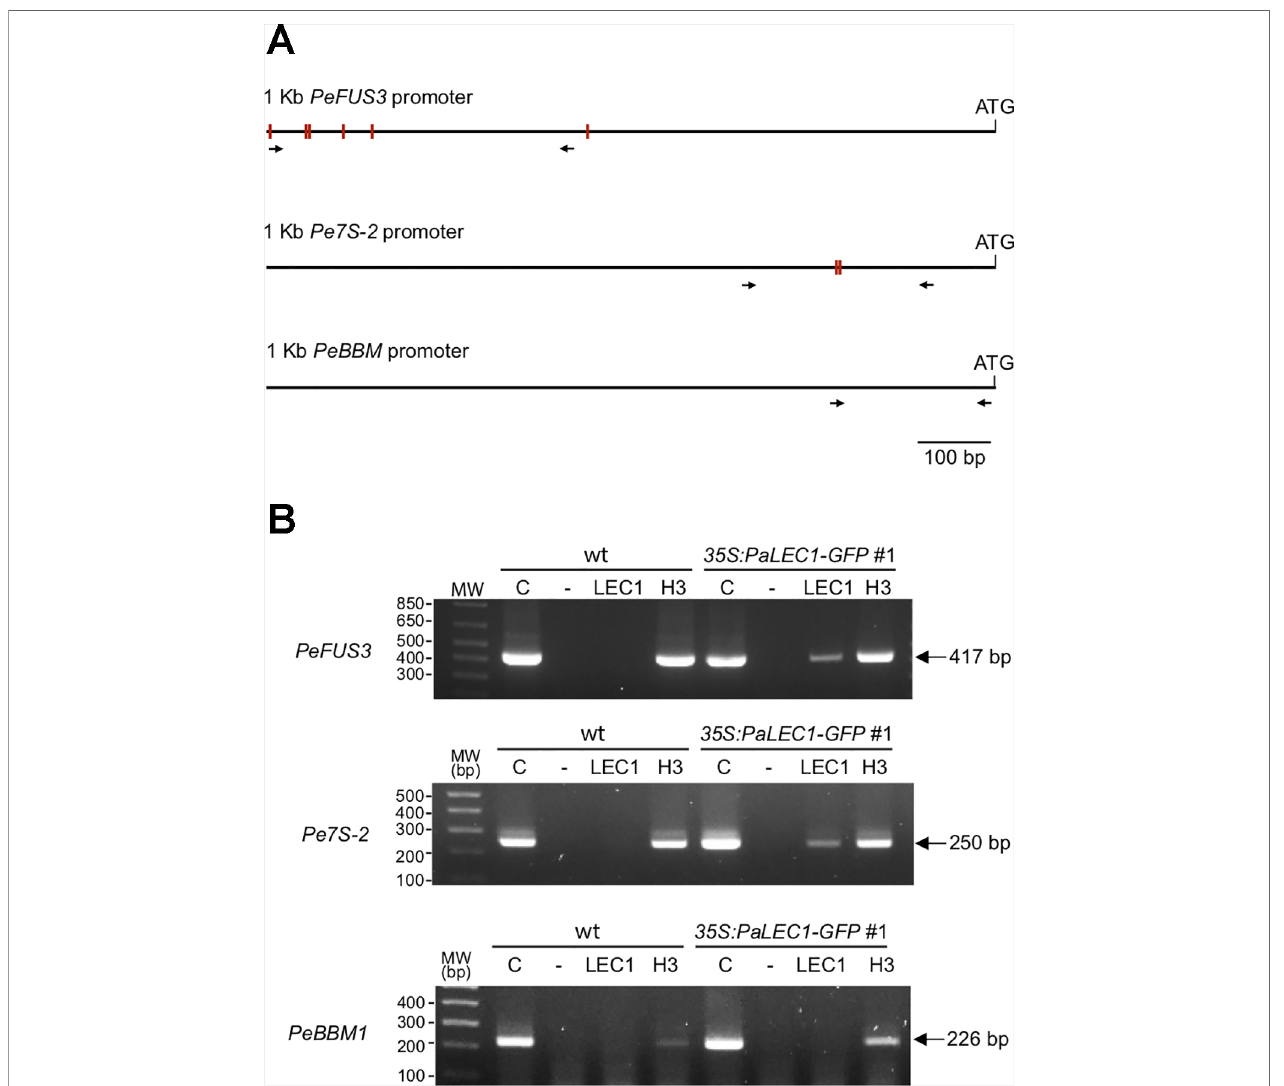
FIGURE 8 | Interaction between PaLEC1-GFP protein and the CCAAT element containing promoters. (A) Schematic representation of distribution of the CCAAT elements (red rectangles) in 1 kb upstream of the start codon of PeFUS3 and Pe7S-2 genomic DNAs. No CCAAT element was found in 1 Kb promoter region of PeBBM . Primers used for PCR reactions were shown as black arrows. (B) PCR of chromatin immunoprecipitation isolated DNA fragments to con fi rm interaction between PaLEC1-GFP protein and the CCAAT-containing promoters of the indicated genes. C, total cell lysate; “ - ” , no antibody control; PaLEC1, PaLEC1 antibody precipitated chromatin; H3, histone H3 antibody precipitated chromatin. The ampli fi ed PCR fragments were veri fi ed by DNA sequencing. The same result was validated in two other independent biological samples ( Supplementary Figure S8